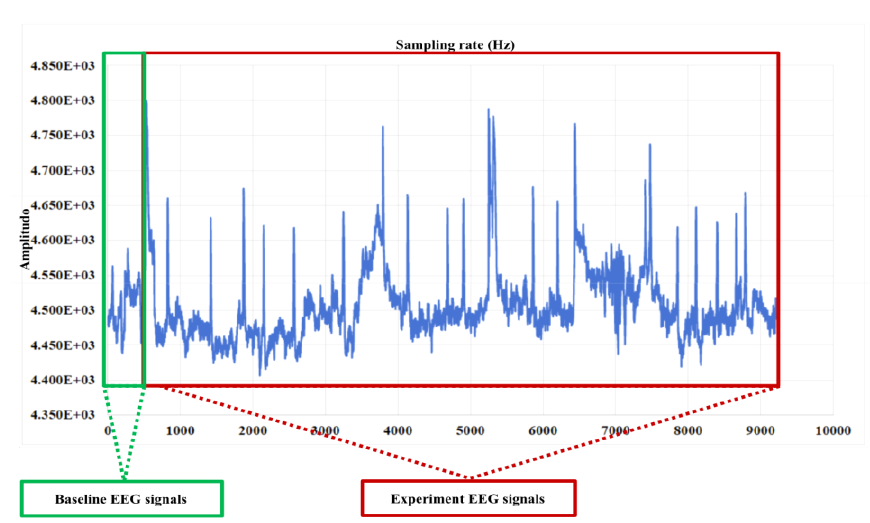
Figure 4. Raw EEG signals for AF3 from the DREAMER data set